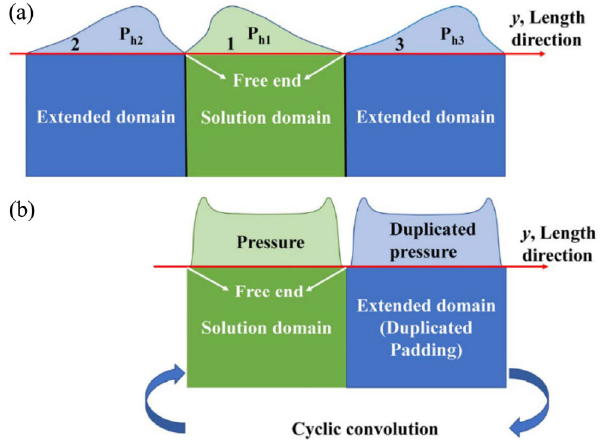
Fig. 63 Modelling pressure-induced horizontal-surface normal deformation of a finite roller. (a) Overlapping model and (b) DCD-FFT method [886]. Reproduced with permission from Ref.